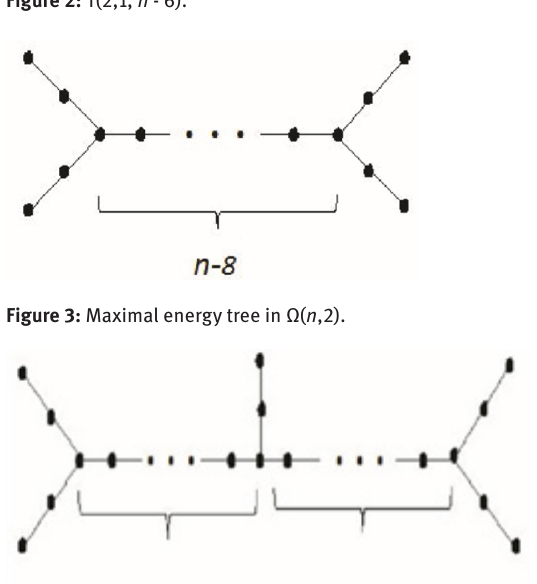
Figure 2: T(2,1, n - 6).